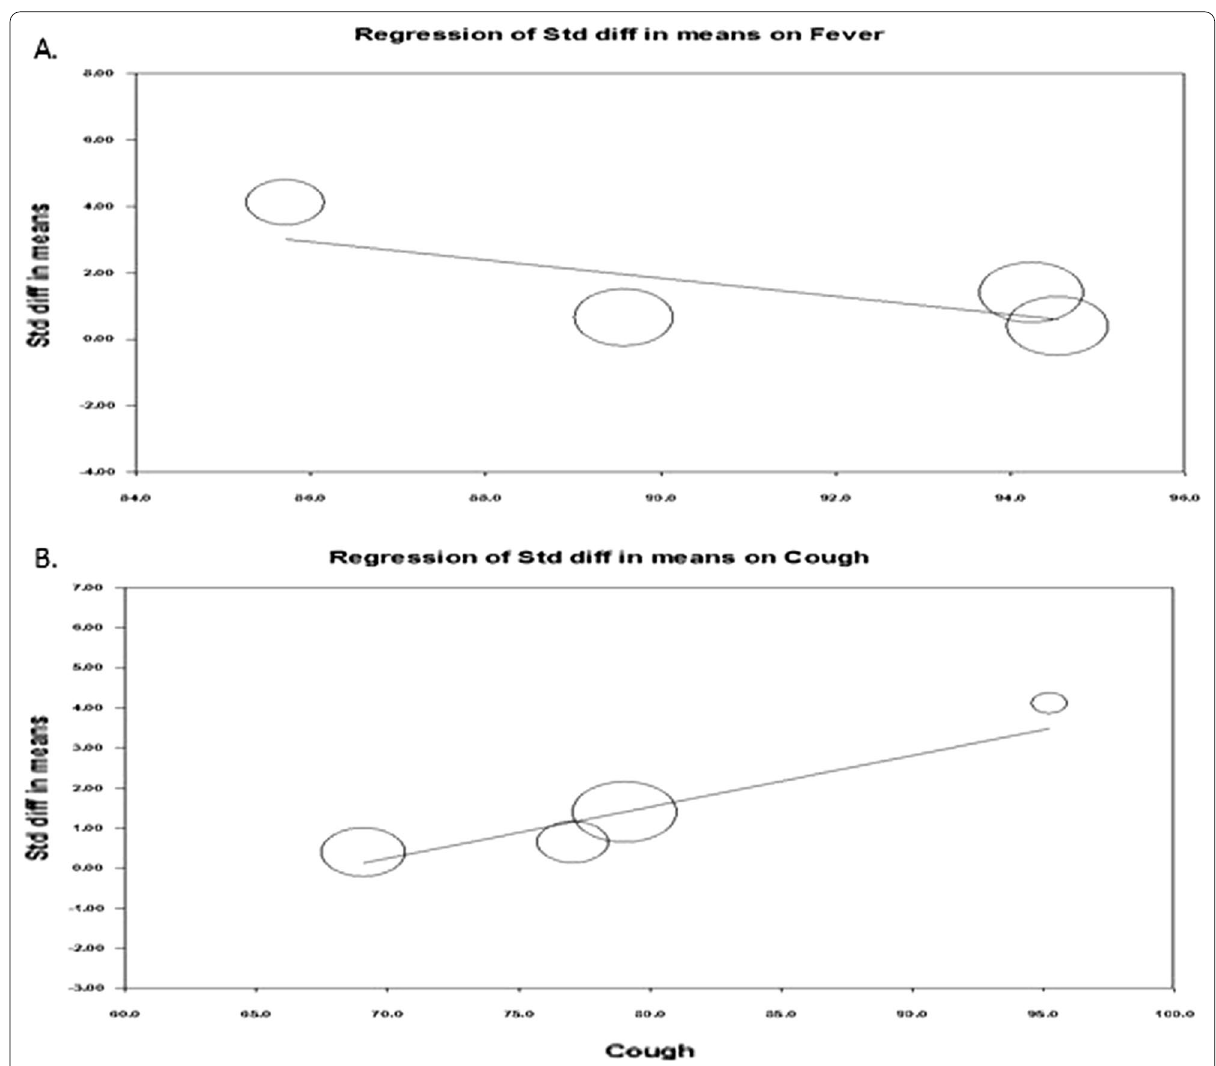
Fig. 10 Regressin analysis of effect size on covariates fever rate ( A ) and cough rate ( B